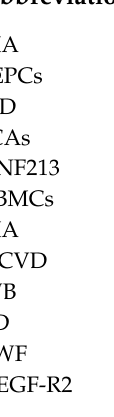
s1. Table S1: Demographic, clinical and neuroradiological features of 47 MA patients, Table S2: Multivariate linear regression of EPC counts with regard to clinical characteristics of MA patients, considering both heterogeneous ( n = 47) and homogeneous ( n = 22) group, Table S3: VEGF-A, HGF, TGF- β 1, CCL5 / RANTES, CCL2 / MCP-1 and IL-8 / CXCL8 concentration (pg / mL) in conditioned media collected from EPC cultures at 7 and 17 days after seeding, Figure S1: Flow cytometer analysis of circulating